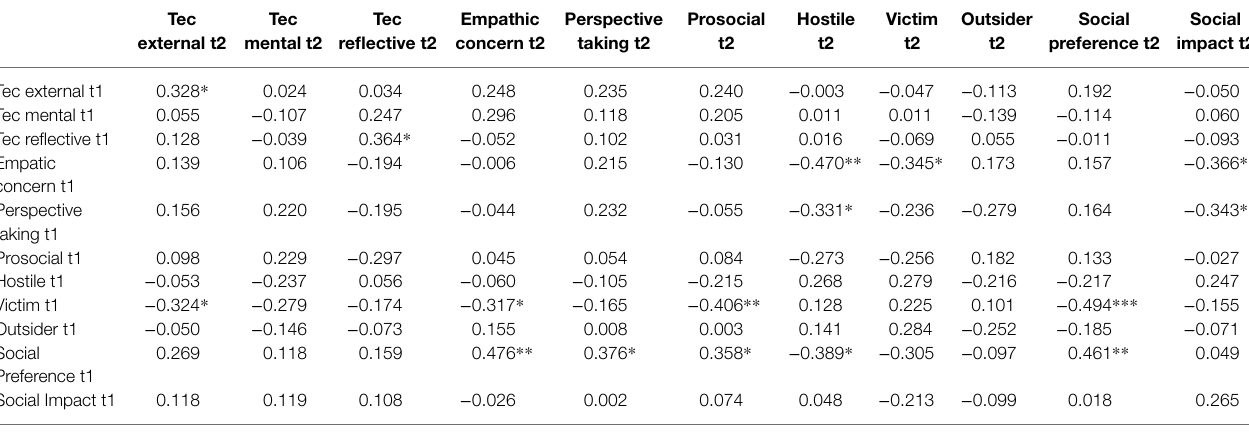
TABLE 1 | Correlational pattern among variables at t1 and t2 (Pearson’s r ).